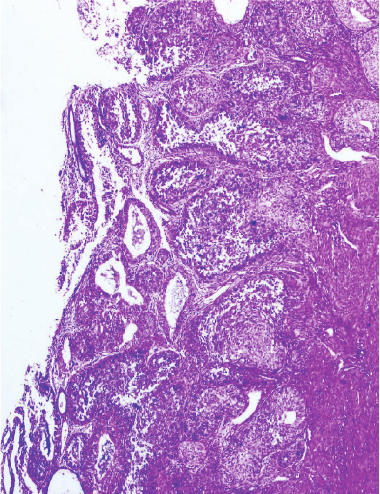
Figure 6: Positive staining for estrogen